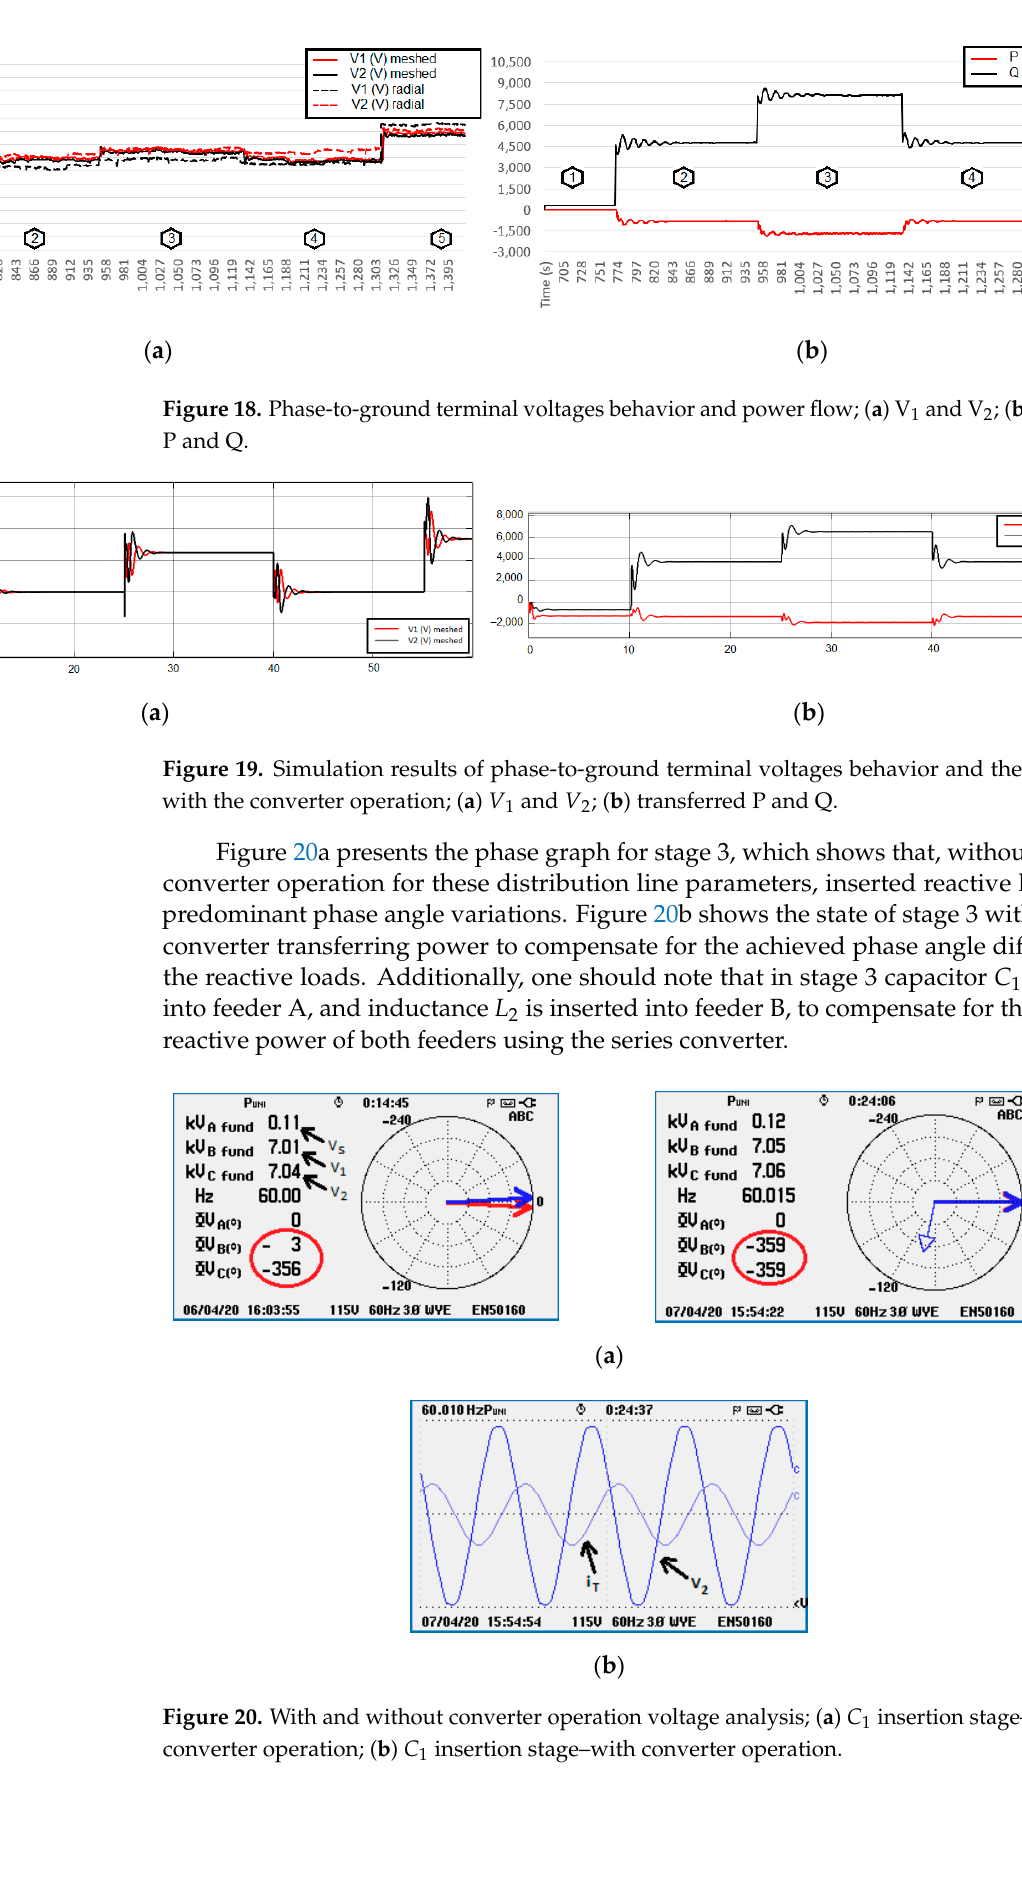
( b ) Figure 20. With and without converter operation voltage analysis; ( a ) C 1 insertion stage–without the converter operation; ( b ) C 1 insertion stage–with converter operation.